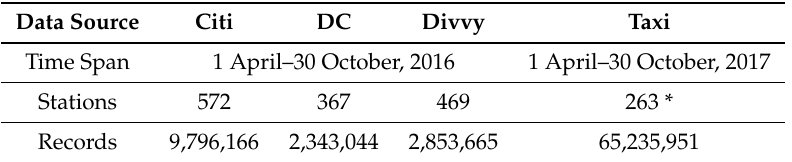
Table 1. Details of the